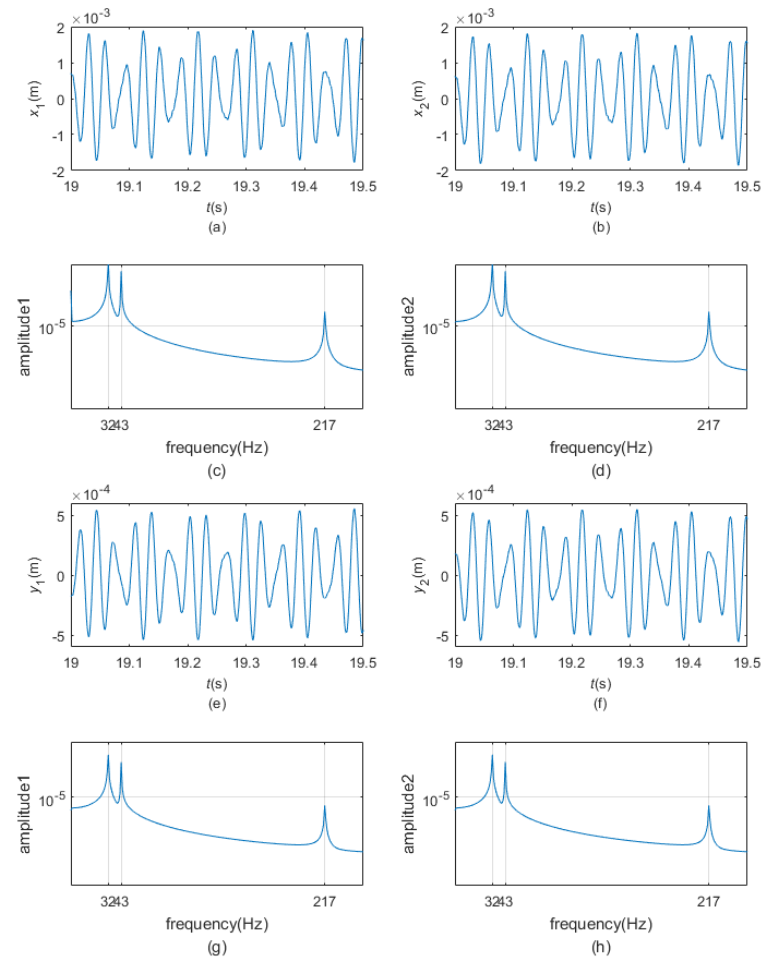
Figure 18. The motion and frequency spectrums of the dampers in the x direction ( a, b, c, d ); the motion and frequency spectrums of the dampers in the y direction ( e, f, g, h ).